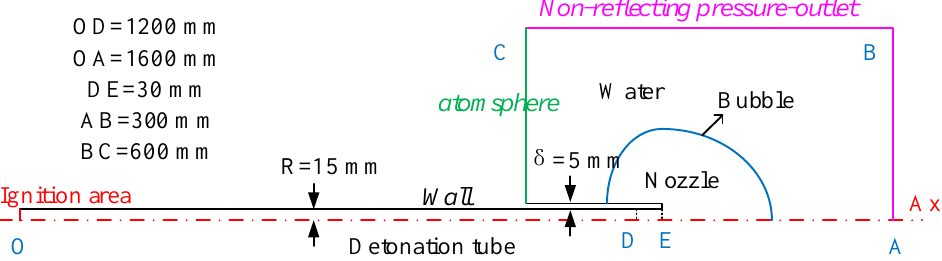
Figure 3. Calculation domain of the underwater detonation gas jet.